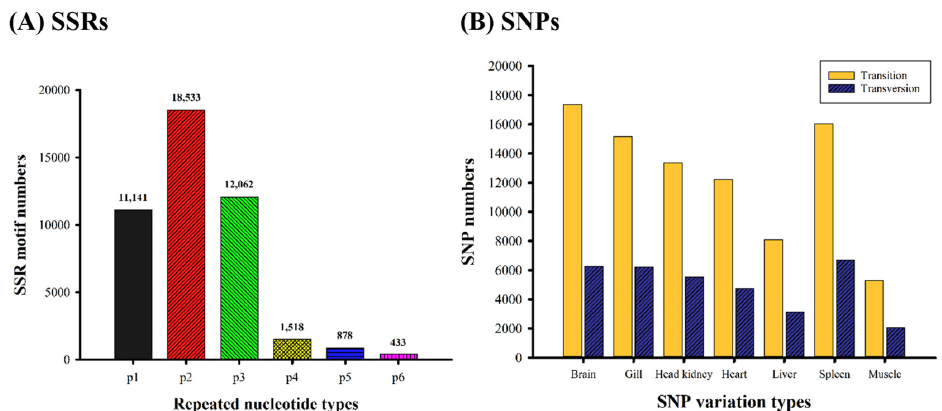
Figure 3. Distribution of different SSR motif types ( A ). The numbers of SNP variations in different tissues ( B ). Abbreviations: p1, mononucleotide; p2, dinucleotide; p3, trinucleotide; p4, tetranucleotide; p5, pentanucleotide; p6, hexanucleotide.